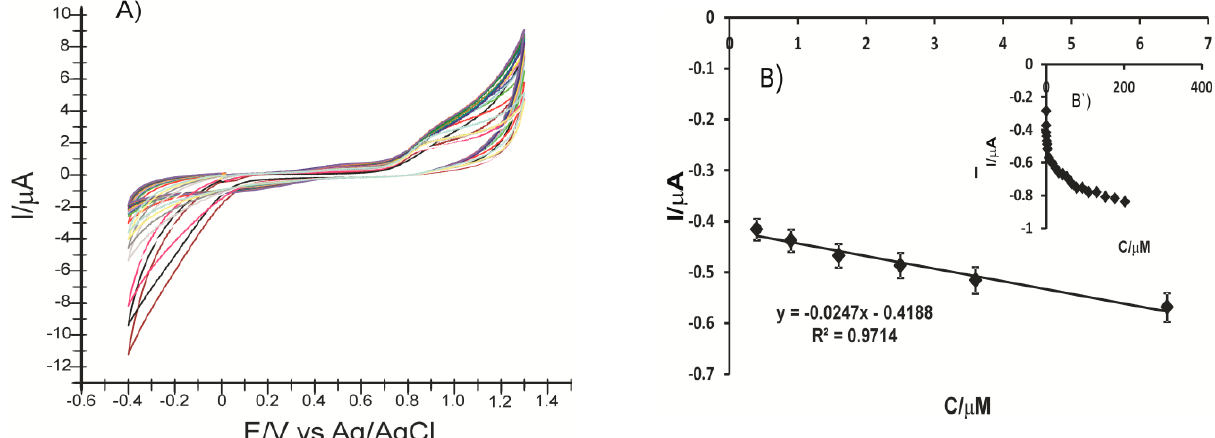
Table 3. Equation of linear dependence between I pc and c, R 2 , LOD, and LOQ for CNF-CoPc-Lac/SPE. Electrode Linear Equation R 2 LOD (M) LOQ (M) CNF-CoPc-Lac/SPE